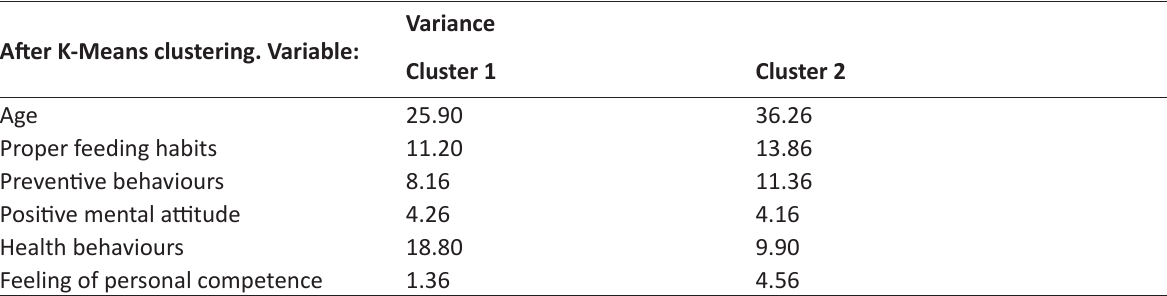
After K-Means clustering. Variable: